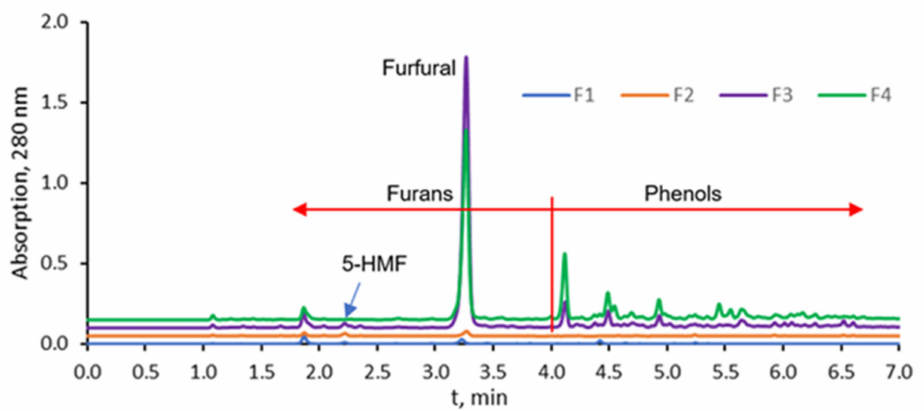
Figure 2. UHPLV-UV chromatograms ( λ = 280 nm) of the main fractions of pyrolysis waste streams. Table 2. UHPLC-UV analysis for the slow pyrolysis volatile product fractions. Compounds F1 F2 F3 F4 5-HMF, µ g/g 0.13 0.42 1.2 n Furfural, µ g/g 0.74 0.14 32 15 Furan (1.87 min *), rel. units 0.14 0.047 0.24 0.23 Furans (<4 min *), rel. units 0.31 0.30 7.0 5.0 Phenols (>4 min *), rel. units 0.12 0.12 2.1 4.4 Phenol (4.12 min *), rel. units n n 0.40 1.0 Phenol (4.42 min *), rel. units 0.05 n 0.03 0.05 Phenol (4.49 min *), rel. units n n 0.20 0.34 Phenol (4.54 min *), rel. units n n n 0.17 Phenol (4.93 min *) rel. units n n 0.17 0.28 Phenol (5.45 min *), rel. units n n 0.19 Phenol (5.55 min *) rel. units n